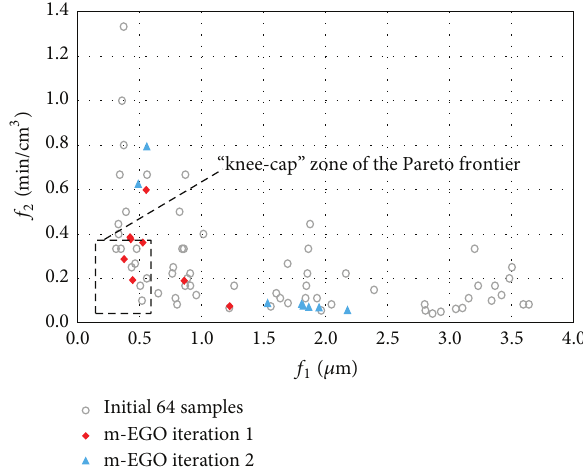
Figure 4: Objective values for samples obtained via m-EGO approach.